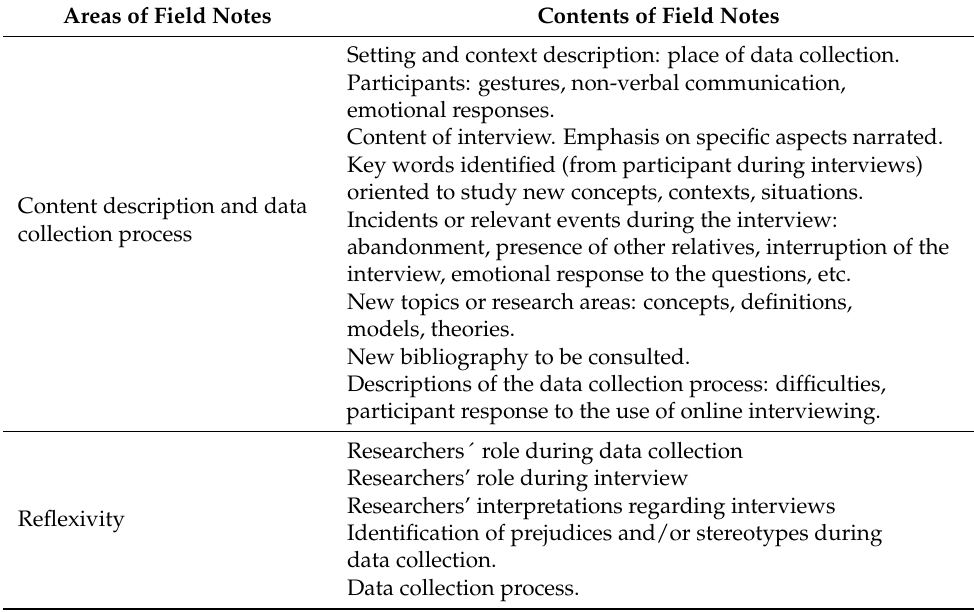
Table 2. Researcher ´ s field notes